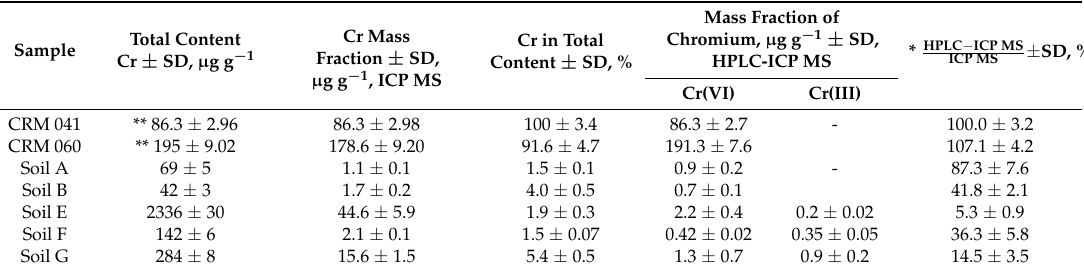
Table 3. Mass fraction of chromium extracted with Na 2 CO 3 from soil determined by ICP MS and IP RP HPLC-ICP MS methods (mean value ± standard deviation, n =